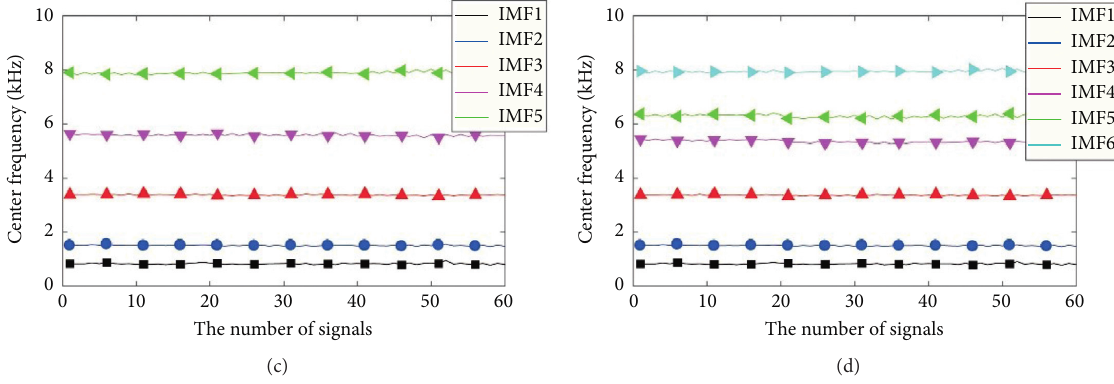
Figure 11: Center frequency distribution of 60 samples under normal state. (a) K � 3. (b) K � 4. (c) K � 5. (d) K � 6.